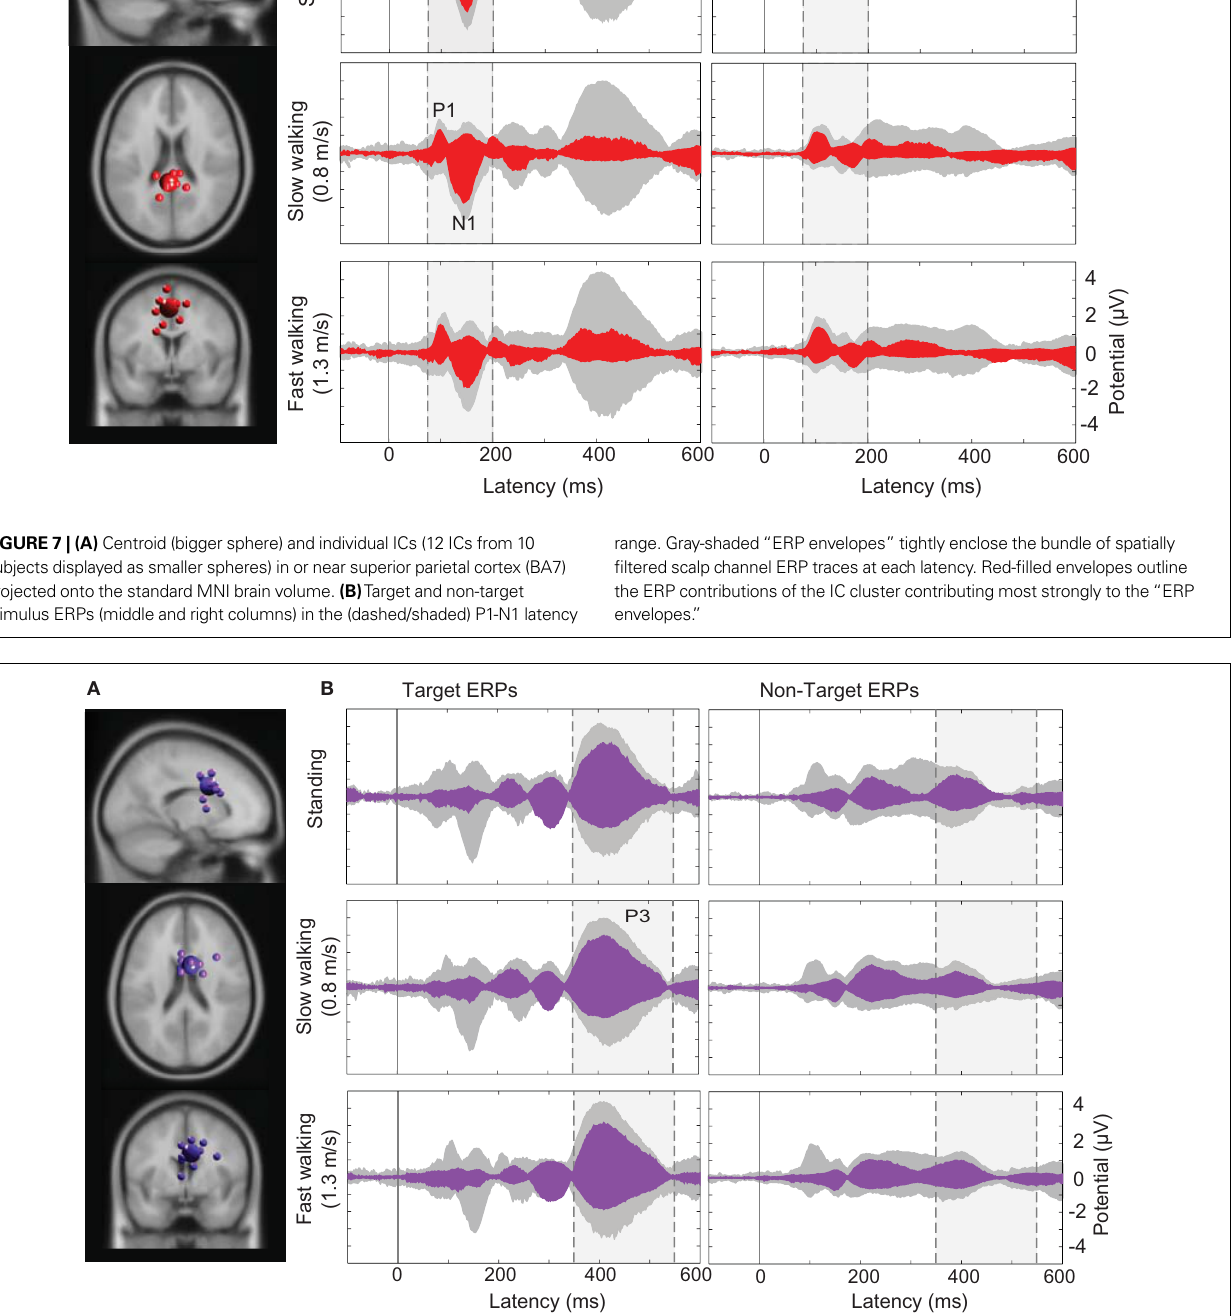
stimulus ERPs (middle and right columns) in the (dashed/shaded) P3 latency range. Gray-shaded “ERP envelopes” enclose the bundle of spatially fi